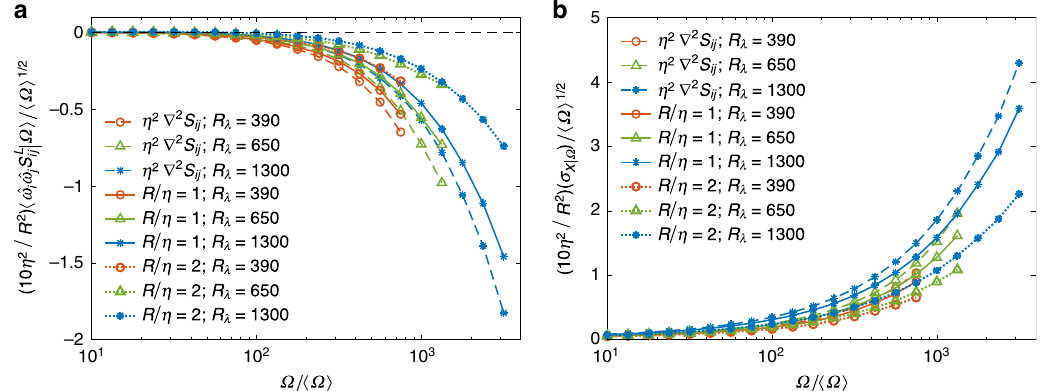
Fig. 2 Negative contribution of local strain to production of enstrophy. a Averaged enstrophy production due to the local strain, P L Ω , conditioned on enstrophy normalized by its mean value. The curves shown correspond for R / η = 1 and 2, at Taylor-scale Reynolds numbers R λ = 390 – 1300. For comparison, we also show the contribution based on η 2 ∇ 2 S ij , which is the limiting value of local strain for small R as noted in Eq. (7). (Accordingly the curves for R / η = 1 and 2 are also adjusted by a factor of 10 η 2 / R 2 ). b The conditional root-mean-square σ X ∣ Ω of the local enstrophy production